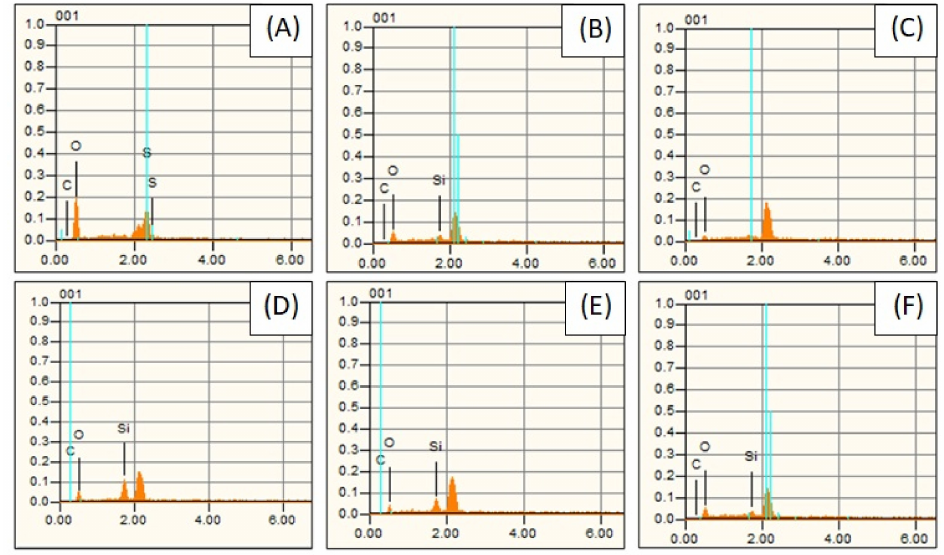
Figure 7. EDS analysis of graphene oxides ( A ) GO1, ( B ) GO2, ( C ) GO3, ( D ) GO1-GPTMS, ( E ) GO2- GPTMS, and ( F ) GO3-GPTMS.